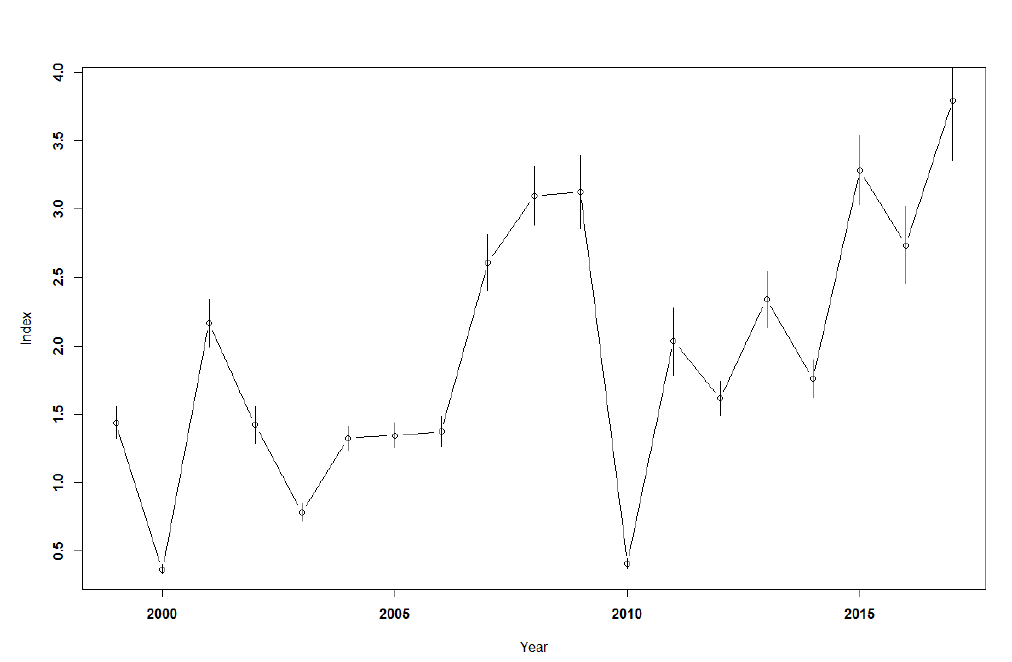
Figure 72. Index of relative abundance of horseshoe crab (delta mean catch per tow) developed from the Georgia Trawl survey with 95% confidence